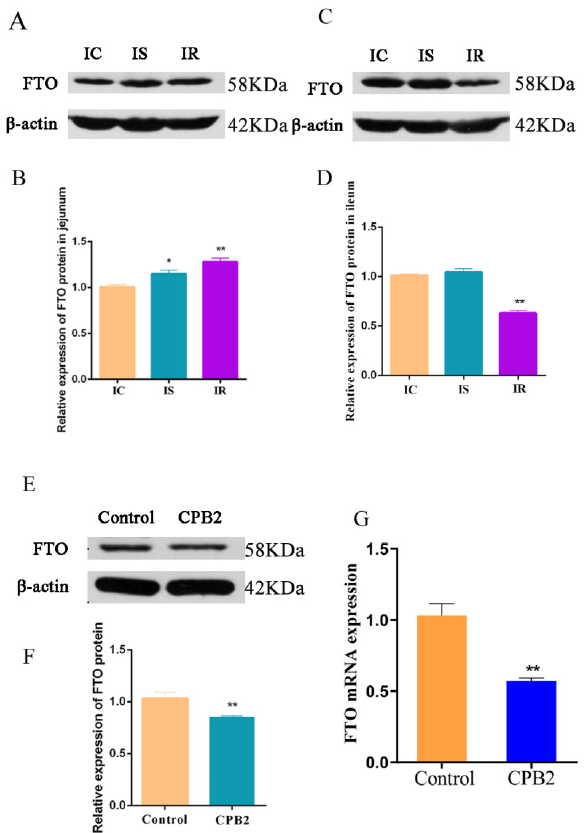
reduced FTO expression.